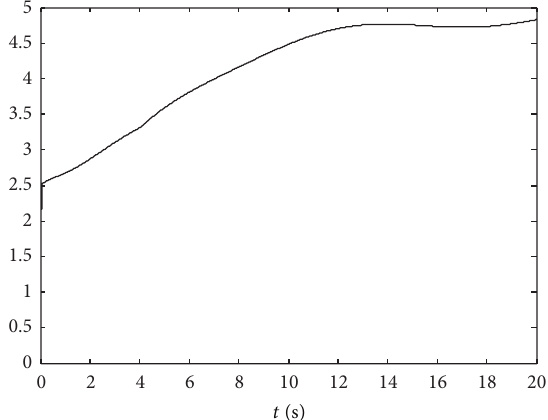
Figure 7: Updating of ̂𝑎(𝑡) with the proposed control scheme ((30a), (30b), (30c), (30d), and (30e)).